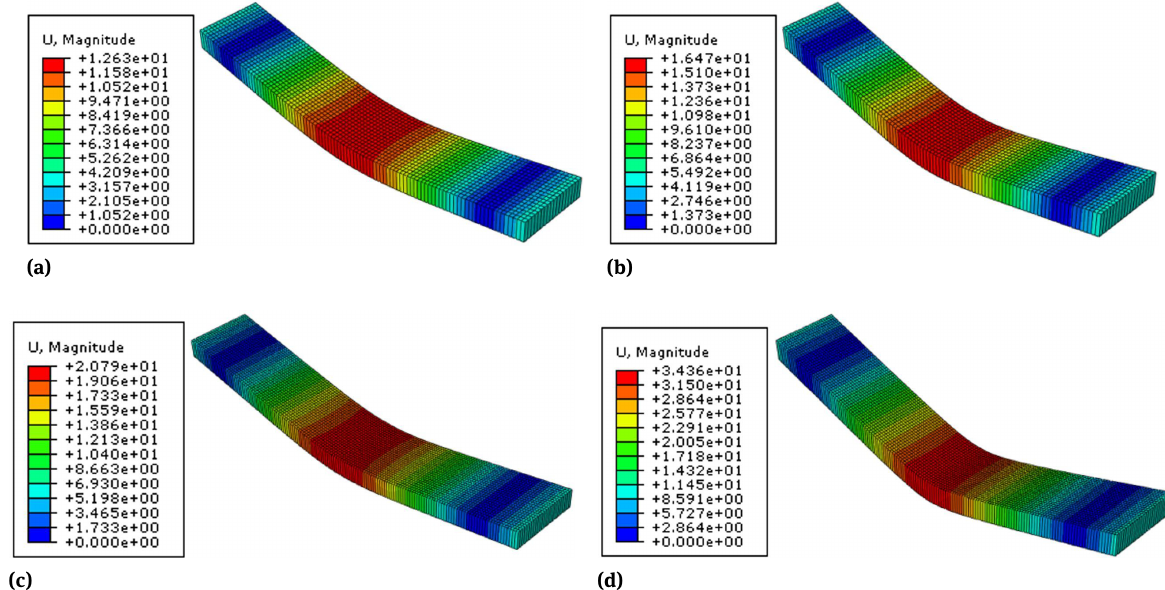
Figure 17: Estimation of deformation through general static method (with plasticity): (a) laminate type 1, (b) laminate type 2, (c) laminate type 3, (d) laminate type